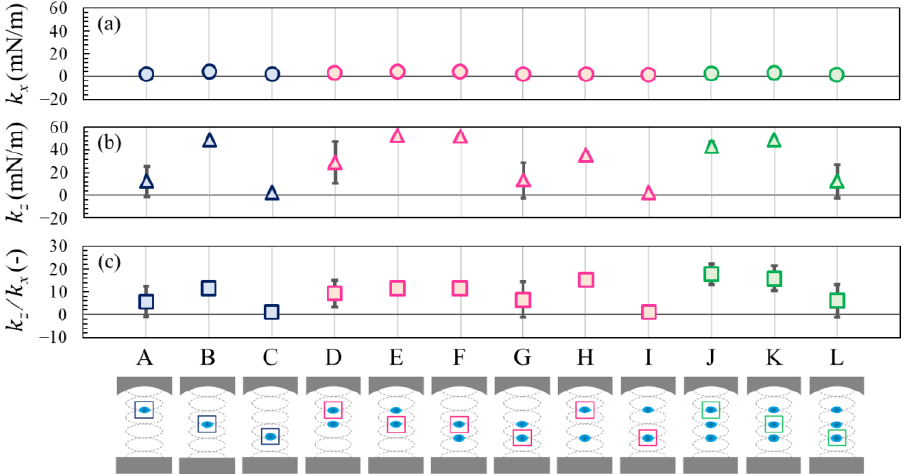
Figure 7. Restoring force coefficient for all cases. ( a ) Horizontal and ( b ) vertical oscillations. ( c ) Restoring force coefficient ratio for each case. The average values were used for each plot, and the error bars represent the standard deviations of the three experiments. The solid line represents k x = k z = k z / k x = 0.